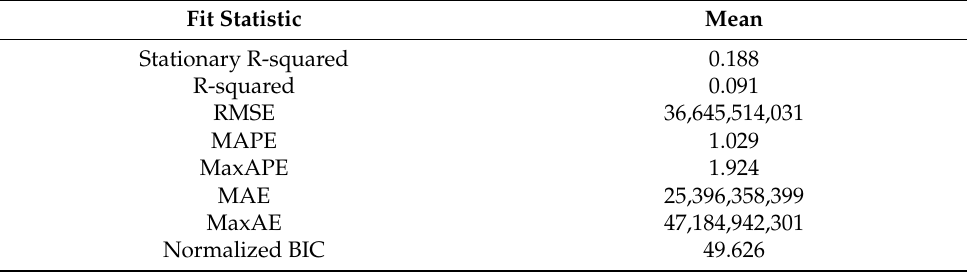
Table 2. Model fit for ARIMA forecast of final energy consumption for electricity source. Fit Statistic Mean Stationary R-squared 0.188 R-squared 0.091 RMSE 36,645,514,031 MAPE 1.029 MaxAPE 1.924 MAE 25,396,358,399 Normalized BIC 49.626